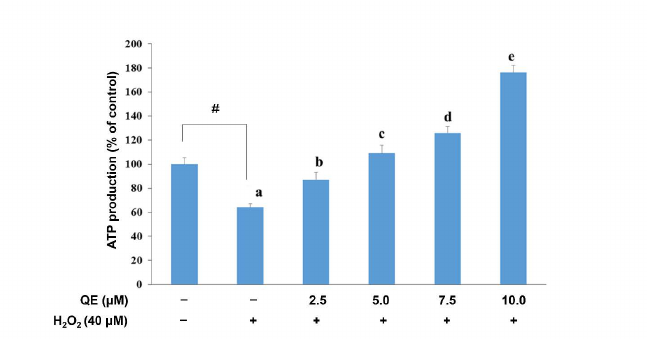
Figure 3. Effects of quercetin and H 2 O 2 on cellular ATP production. Data were presented as mean ± SD. # Data are analyzed using an independent t -test and are significantly different from the control group. Bars of 0, 2.5, 5.0, 7.5, and 10.0 µ M quercetin with different letters significantly differ. Statistical analysis was performed using a one-way ANOVA, followed by a least significant difference post hoc test ( n =